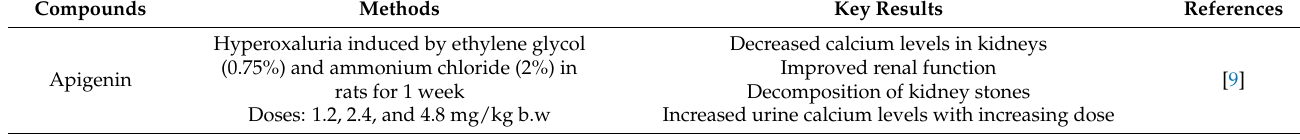
Table 1. Anti-urolithiasis effects of